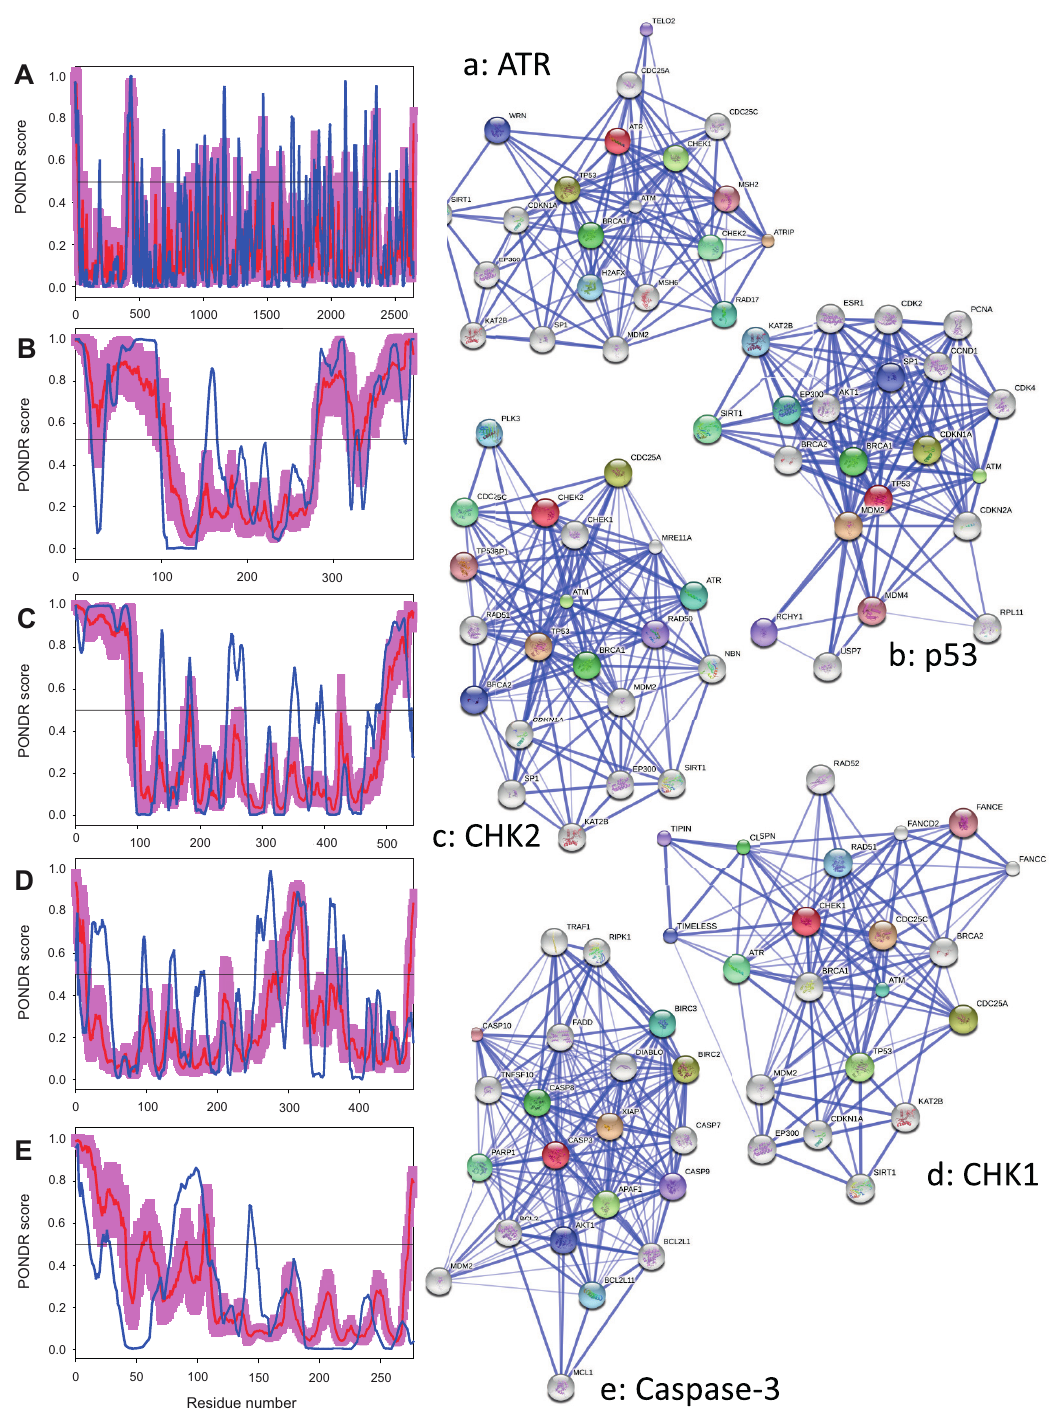
Figure 6. Intrinsic disorder (upper characters) of some human proteins involved in the p53-mediated apoptotic signaling pathways and STRING analysis (lower characters) of their interactomes: group IV. A . and a . ATR (UniProt ID: Q13535); B . and b . p53 (UniProt ID: P04637); C . and c . CHK2 (UniProt ID: O96017); D . and d . CHK1 (UniProt ID: O14757); E . and e . Caspase-3 (UniProt ID: P42574). Intrinsic disorder propensity was evaluated by PONDR-FIT (red curves and pink shadow) and PONDR ® VLXT (blue curves). The shadow around PONDR-FIT curves represents distribution of statistical errors. STRING database is the online database resource search tool for the Retrieval of Interacting Genes, which provides both experimental and predicted interaction information 92 . For each protein, STRING produces the network of predicted associations for a particular group of proteins. The network nodes are proteins. The edges represent the functional associations evaluated based on experiments, search of databases, and text mining. The thickness of edges is proportional to the confidence level 92